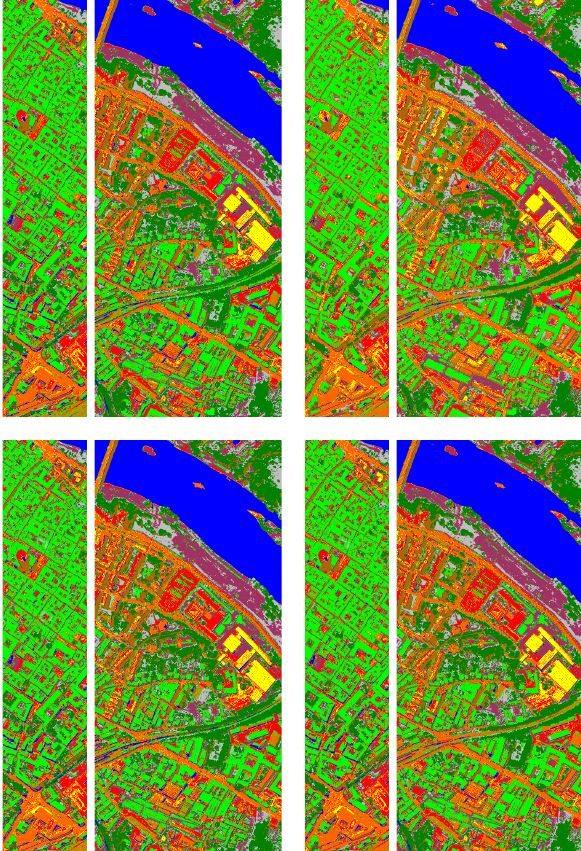
Figure 4. Classified scene for the Pavia Centre dataset when us- ing the original hyperspectral data (top left), the PCA-based en- coding of hyperspectral data (top right), the CFS-based selection of relevant spectral bands (bottom left) and the Sentinel-2-like data (bottom right) as input to a Random Forest classifier: the color encoding follows the definition in Figure 2.